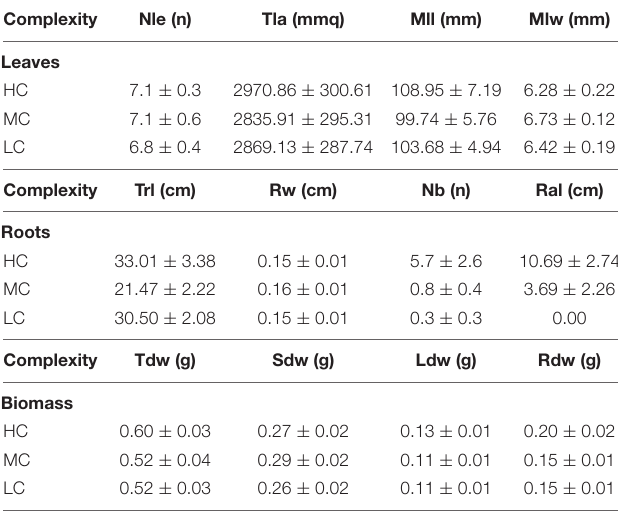
TABLE 1 | Seedling morphological and biomass